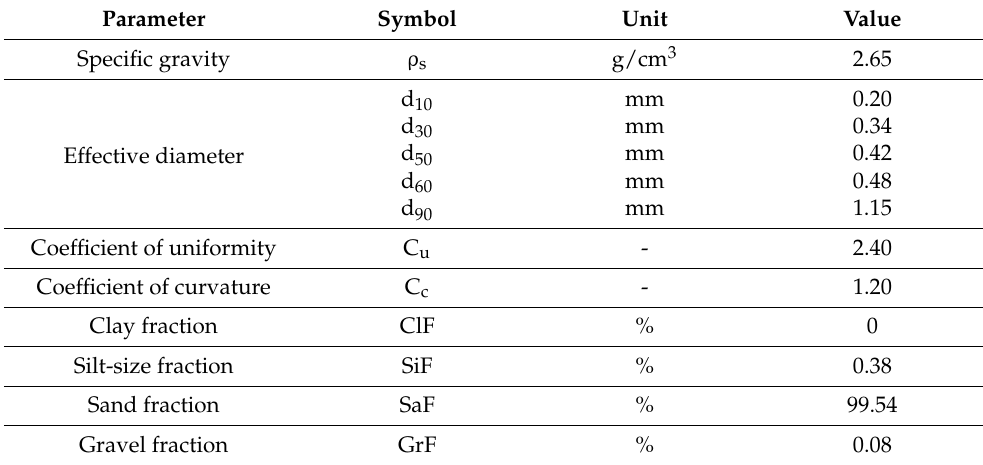
Table 1. Basic physical properties and classification characteristics of medium sand (MSa—SP) from southern Poland.